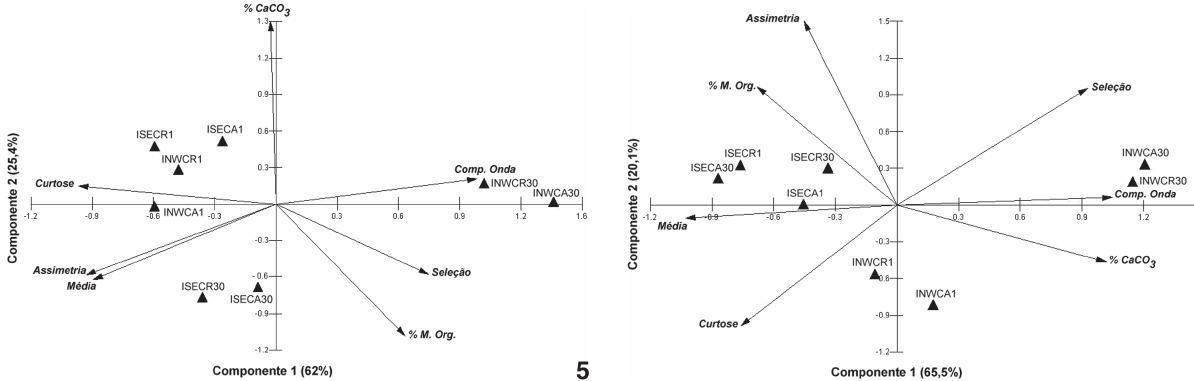
Figuras 5-6. Resultados da análise de Componentes Principais dos parâmetros sedimentológicos da laje submersa nas proximidades das ilhas Itacolomis (I) no verão (5) e no inverno (6); na face exposta (SE) e face protegida (NW); nas cristas (CR) e cavas (CA); nos distanciamentos de 1 e 30